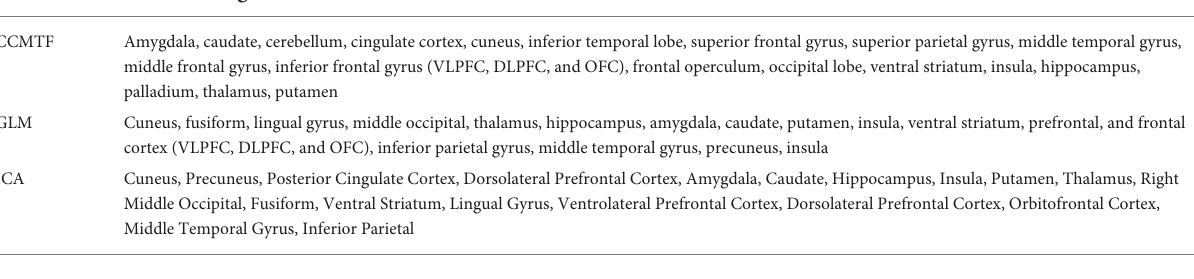
TABLE 1 The extracted activated ROIs obtained by CCMTF, GLM, and ICA methods. Method